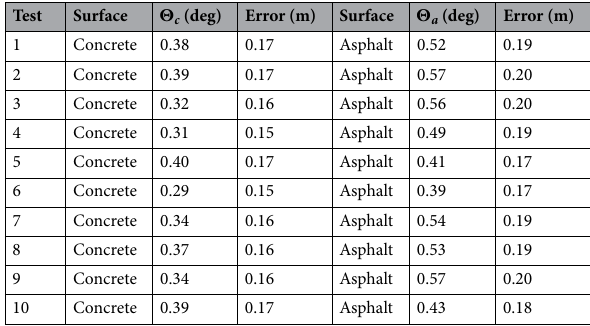
Table 5. Final errors and yaw angle deviation for each test.